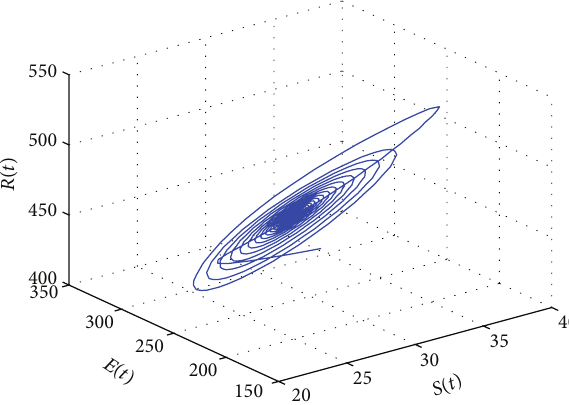
Figure 2: The phase plot of the states 𝑆 , 𝐸 , and 𝑅 for 𝜏 1 = 15.5000 < 17.2530 = 𝜏 10 .